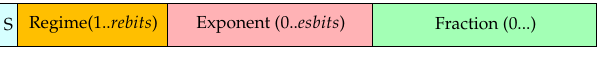
Figure 1. Illustration of the of 32-bit Posit data type.